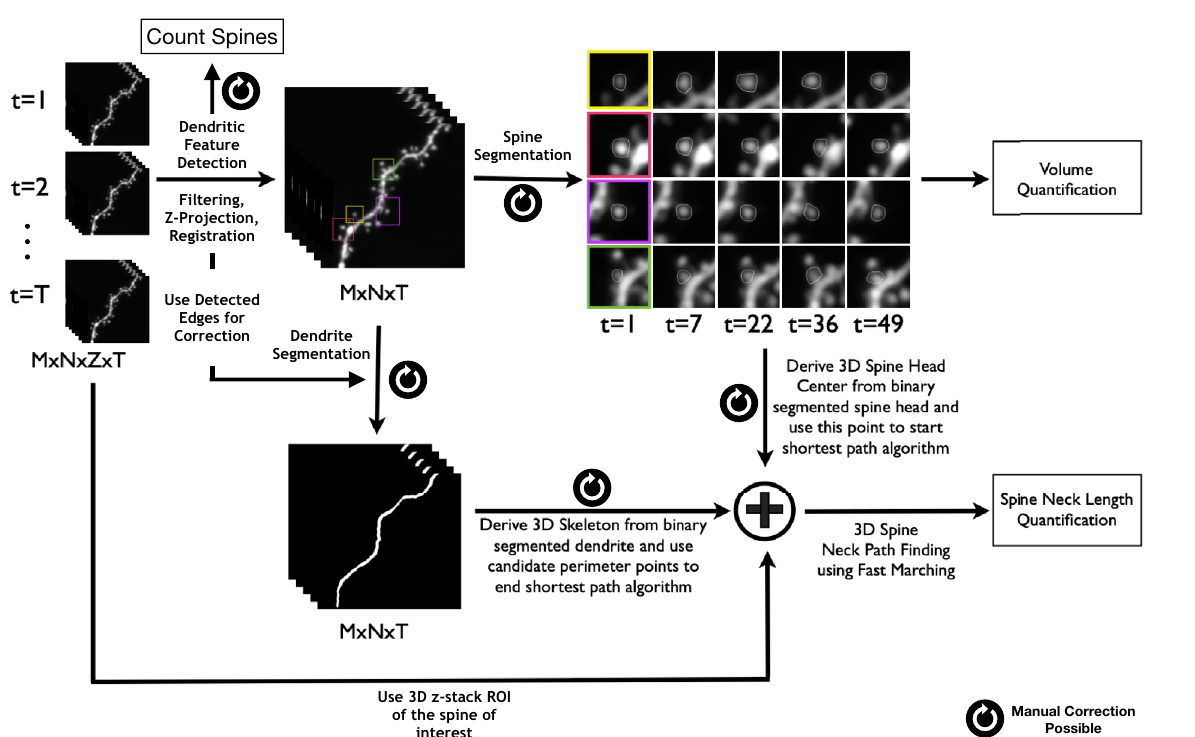
Figure 2. Workflow of SpineS. Z-stacks (M × N × Z) from multiple time points (T) are analyzed. Each z-stack is imported and registered. MIPs are then computed and filtered using median filtering. Dendritic spine heads are detected using a CNN and segmented using a watershed segmentation algorithm followed by a graph-based clustering. Each spine volume is estimated using the integrated fluorescence intensity (IFI) of the spine head within the segmentation region. The intensities in the region are normalized using the median fluorescence intensity of the dendrite at the corresponding time point after background fluorescence subtraction. Neck paths from the spine head center to the closest geodesic point on the dendrite are computed using the fast-marching algorithm by imposing empirically set